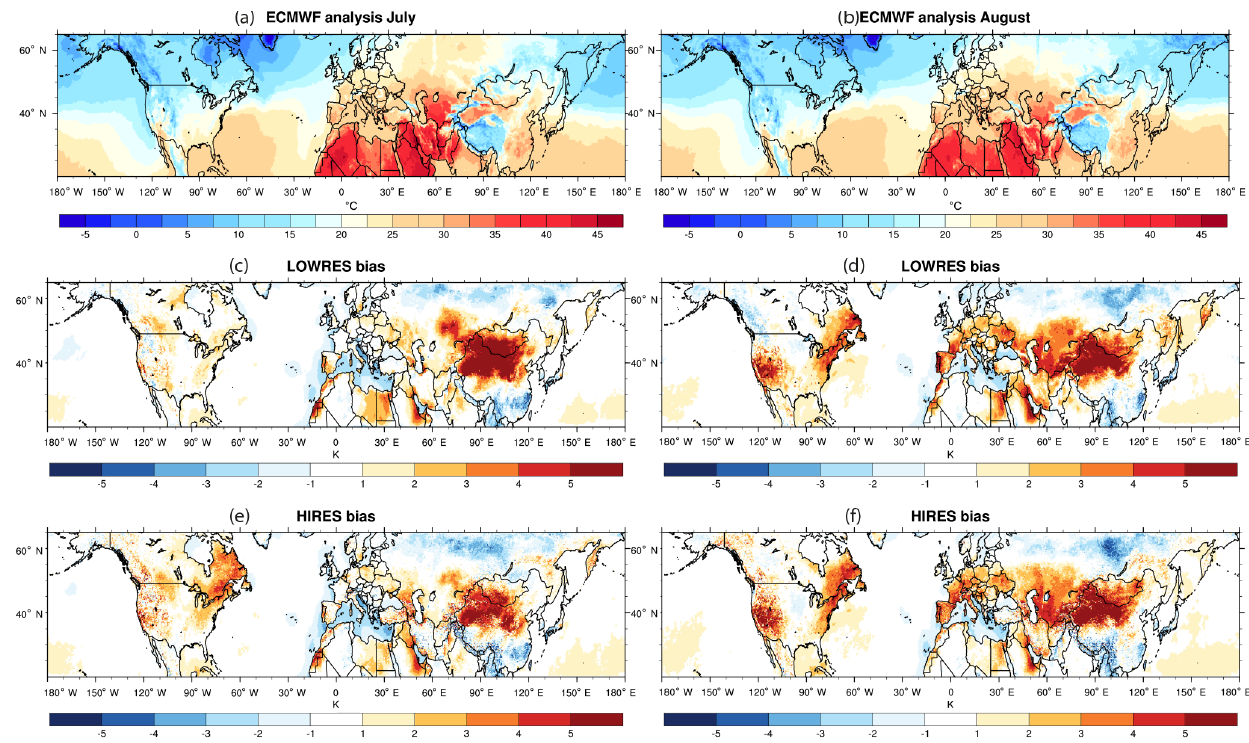
Figure 13. Mean 2m temperature at 12:00UTC in July (a, c, e) and August (b, d, f) . The top row shows the ECMWF analysis, the middle row displays the LOWRES simulation, and the bottom row represents the HIRES simulation. Reddish colors indicate a warm bias of the WRF simulations.